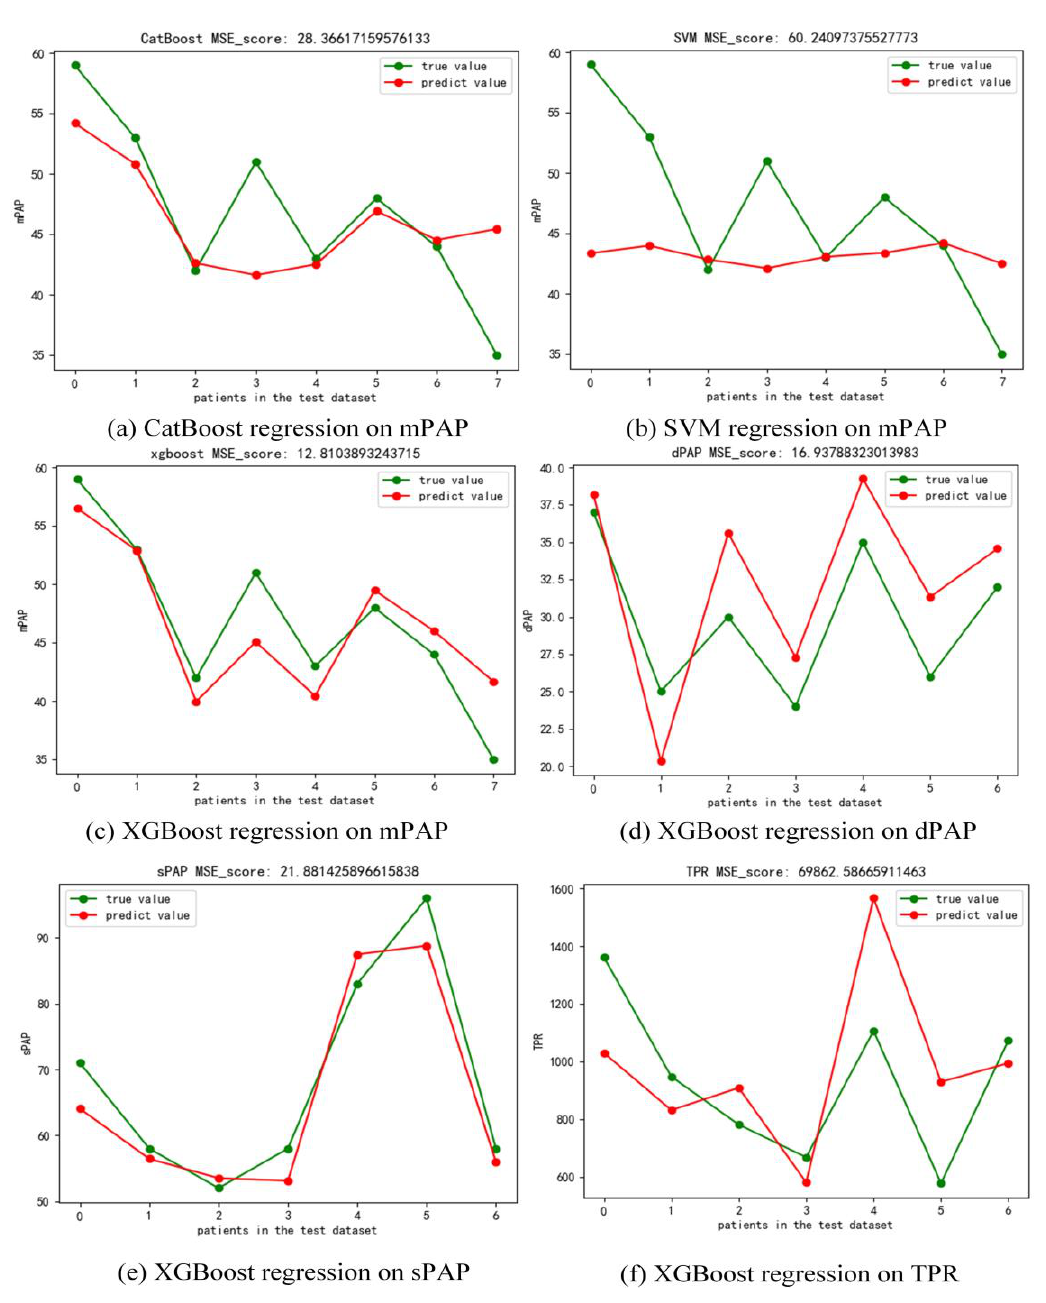
Figure 6. ( a ) CatBoost regression on mPAP (MSE = 28.37), ( b ) SVM regression on mPAP (MSE = 60.24), ( c ) XGBoost regression on mPAP (MSE = 12.82), ( d ) XGBoost regression on dPAP (MSE = 16.94), ( e ) XGBoost regression on sPAP (21.88), ( f ) XGBoost regression on TPR (MSE = 69,862.59). Table 5. ICC of different models and pressure types. 95% Confidence Interval F Test with True Value 0 Lower Bound Upper Bound Value Sig.